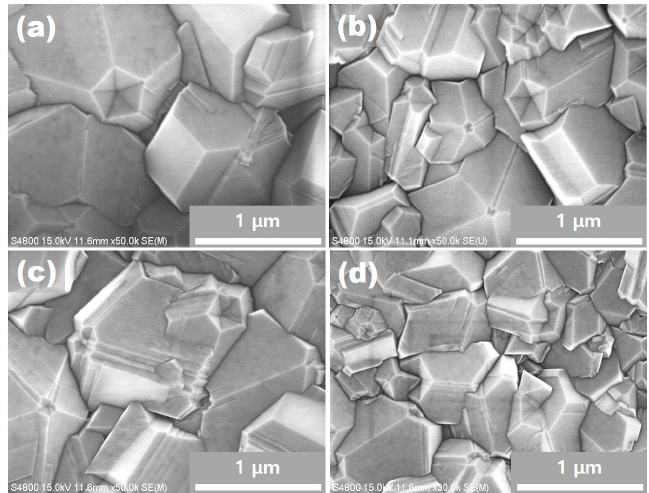
Figure 3. Higher magnification of Figure 2a–d, clearly showing pentagonal dimples. ( a ) 80 sccm; ( b ) 90 sccm; ( c ) 130 sccm; ( d ) 170 sccm.